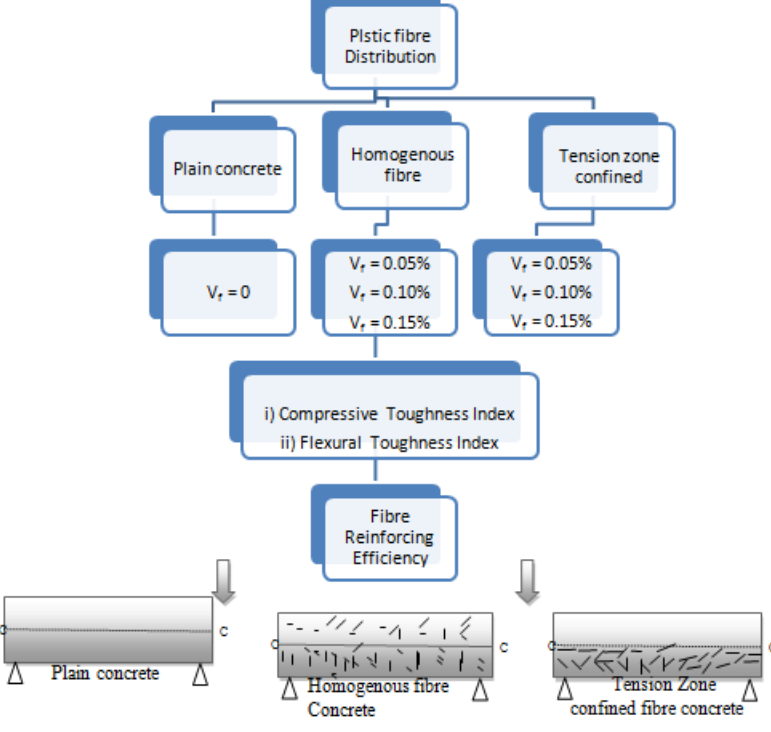
Figure 4. Experimental methodology and layered casting of plastic fibers.